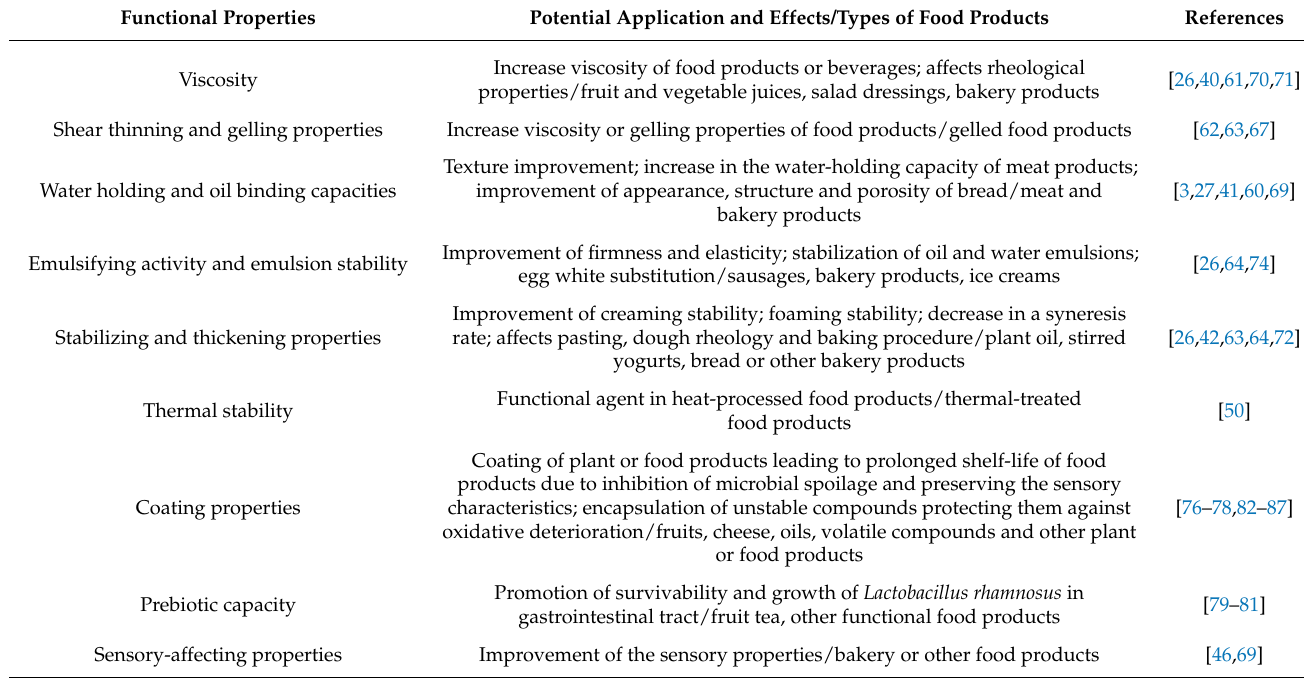
Table 3. Functional properties of flaxseed gum and its potential applications in food